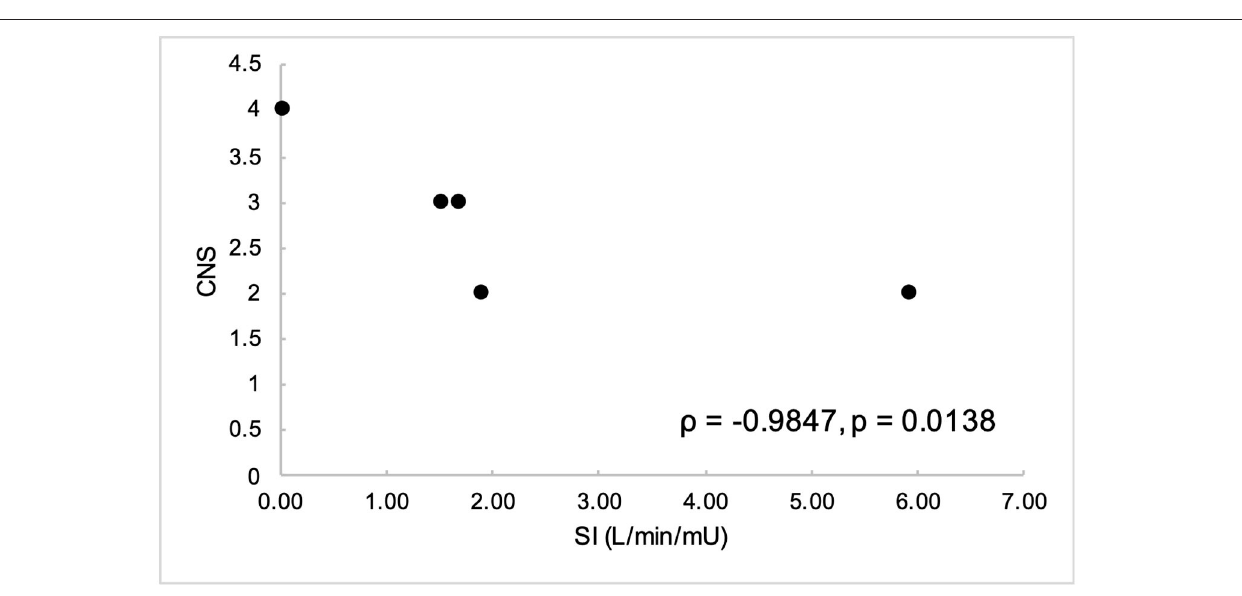
FIGURE 4 | Cresty neck score (CNS) was negatively correlated with insulin sensitivity (S I